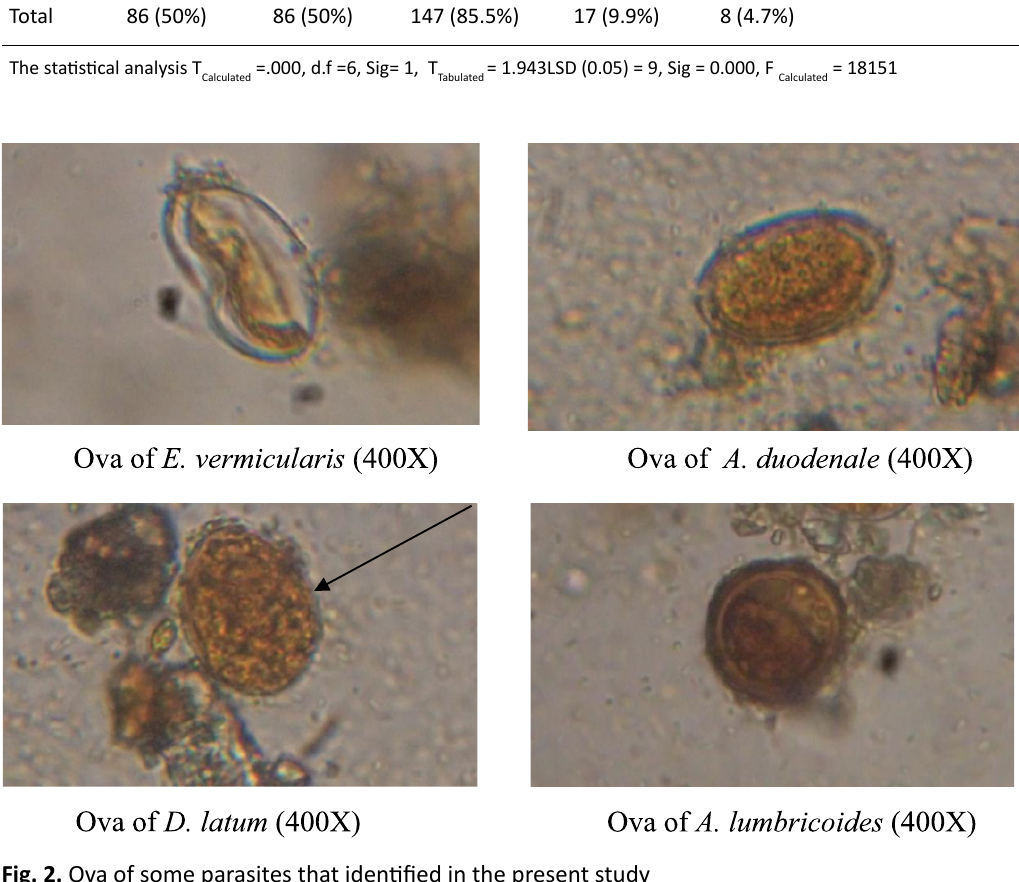
Fig. 2. Ova of some parasites that identified in the present